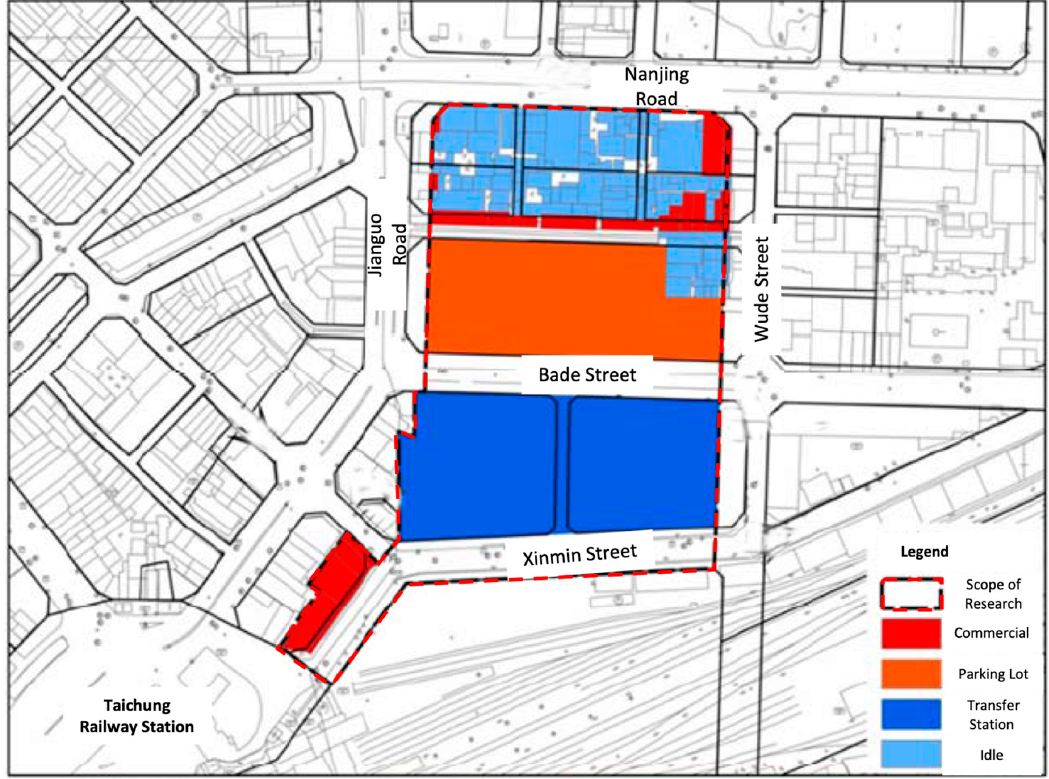
Figure 2. Scope of research. Source: Urban Development Bureau, Taichung City Government, 2018 change to the master planning document of Taichung City (fourth overall review, 35th case) [39].